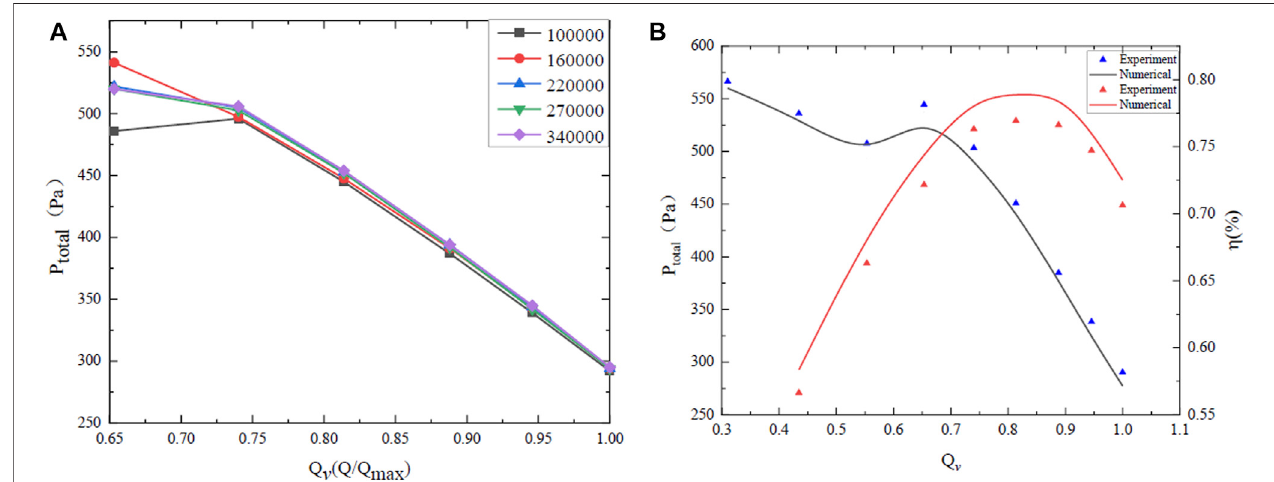
FIGURE 5 | Streamline at single channel region in (A) leading edge and trailing edge, (B) hub and blade, and (C) top of blade.